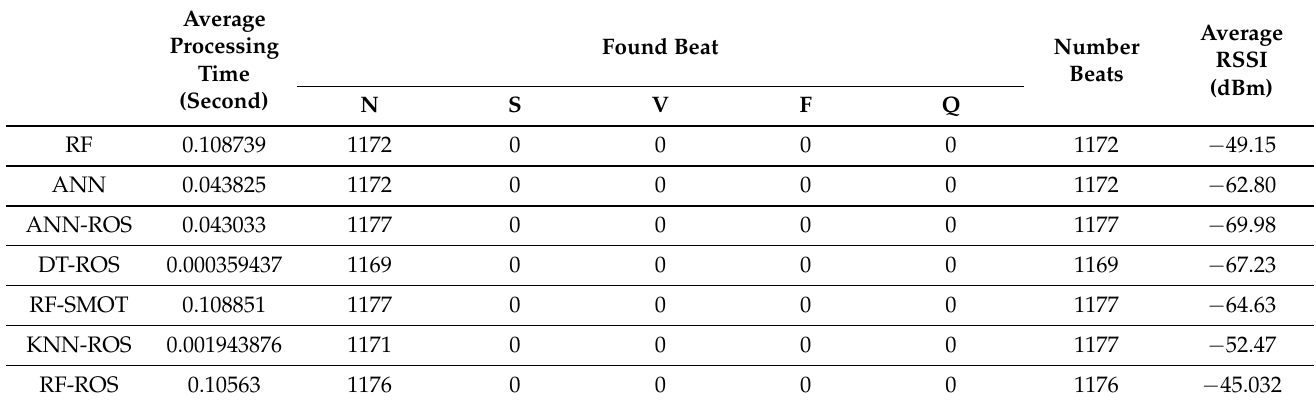
Table 18. Experiment result on healthy person within 20 min.